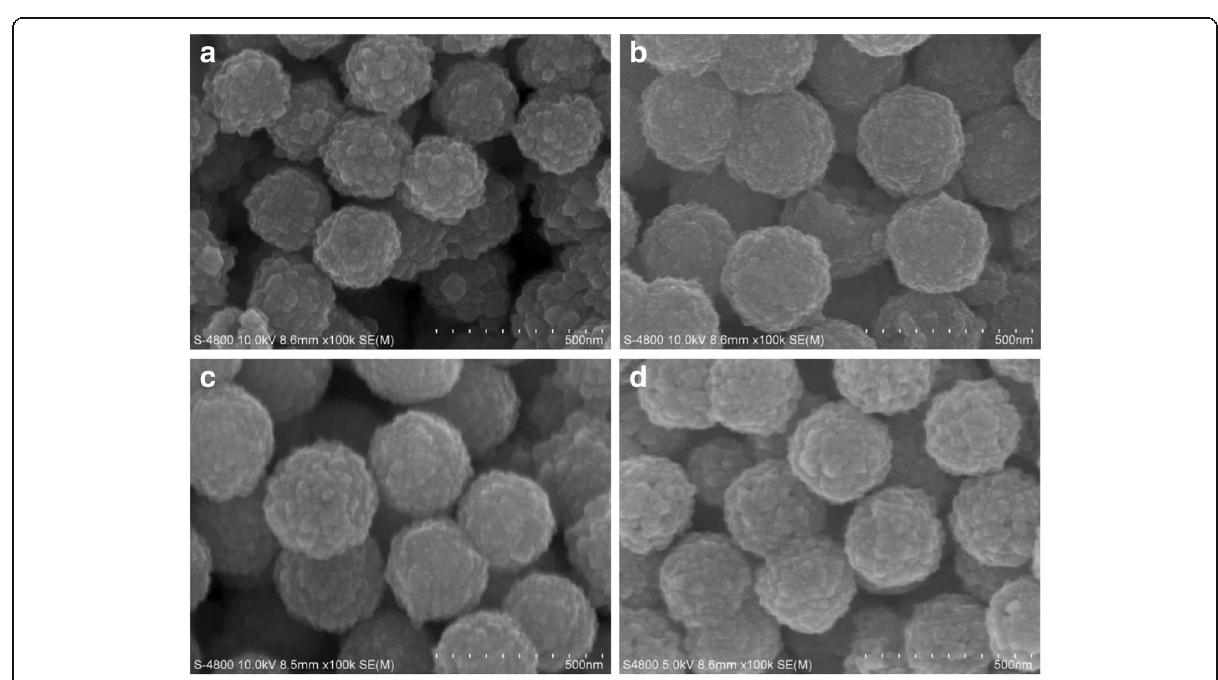
Fig. 4 SEM images of different amount of trisodium citrate synthesized sample. a 3 mmol. b 4 mmol. c 6 mmol. d 8 mmol